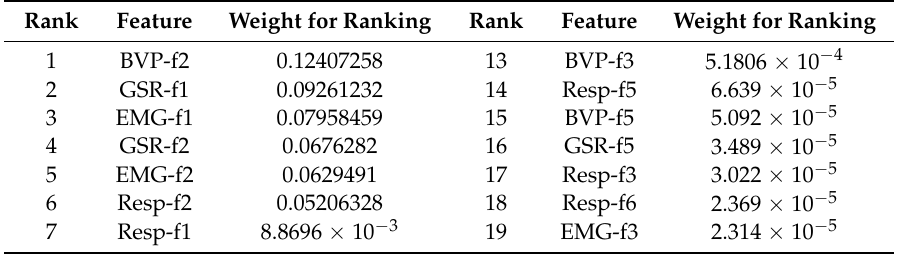
Table 11. Correlation-based ranking for physiological